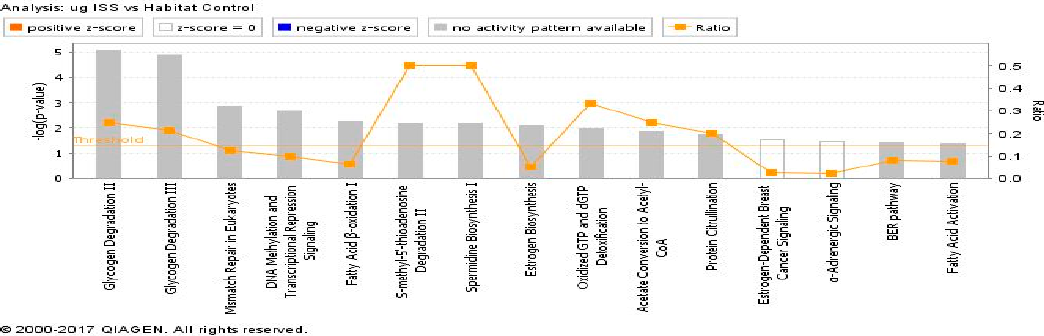
Figure 4. Volcano plots show differentially expressed proteins (FDR adjusted p < 0.05 and fold change >2). ( A ) µg versus HC: 77 significant run in Ingenuity Pathway Analysis (IPA); ( B ) µg + 1 g versus HC: 23 significant run in IPA. Volcano plots were generated based on fold-change of protein levels using the log 2 normalized iBAQ intensities from six biological replicates. The x-axis indicates a log 2 fold-change and the y -axis indicates − log 10 p -value based on a Mann–Whitney U test with a FDR adjusted p -value. The horizontal line indicates a p -value < 0.05 and the vertical lines represent a fold-change >2.